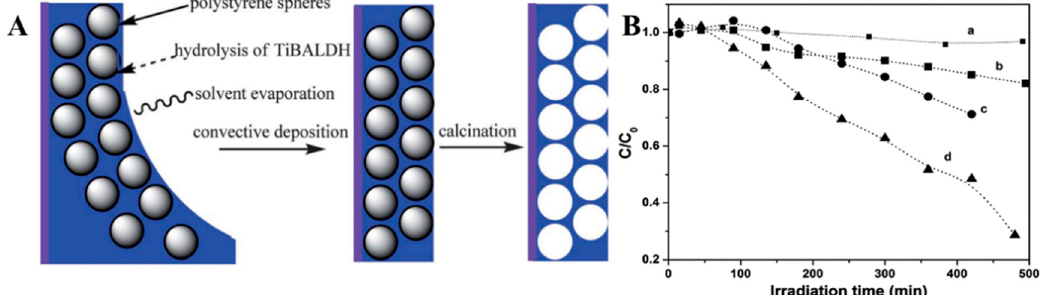
Figure 14. ( A ) Schematic illustration of procedures for the fabrication of 3DOM TiO 2 films loaded with gold nanoparticles. ( B ) Photocatalytic degradation of benzoic acid (BA) over (a) i-Au–TiO 2 -o without UV irradiation, (b) nanocrystalline TiO 2 , (c) i-TiO 2 -o, and (d) i-Au–TiO 2 -o under UV irradiation [355].